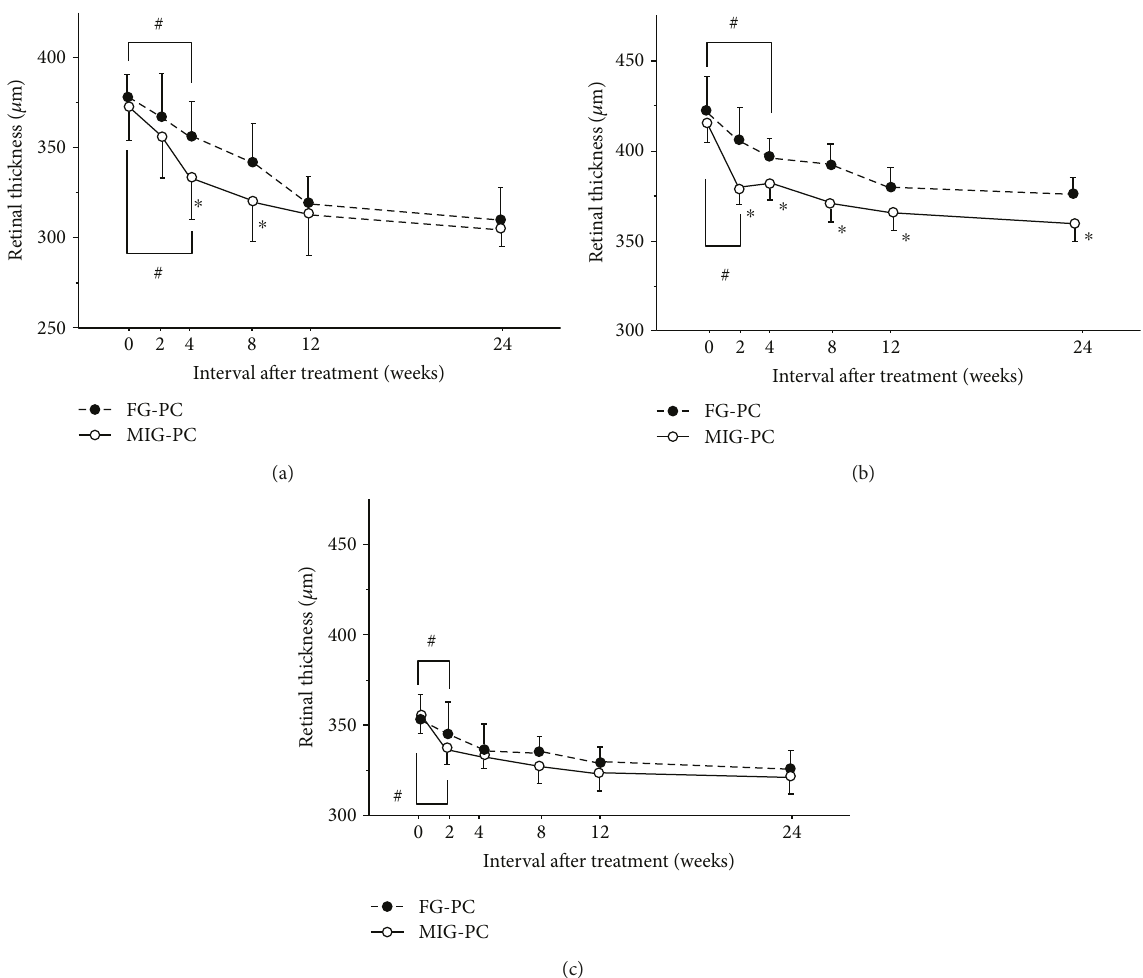
Figure 4: Changes in retinal thickness (RT) in the center (a), inner ring (b), and outer ring (c) after fl uorescein angiography-guided focal photocoagulation (FG-PC) or merged image-guided PC (MIG-PC). Data represent the mean ± standard error (SE). # p < 0 05 (compared with RT at PC initiation) and ∗ p < 0 05 (MIG-PC group versus FG-PC group).